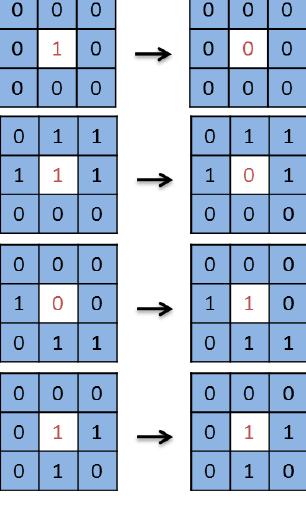
Figure 2. Game of